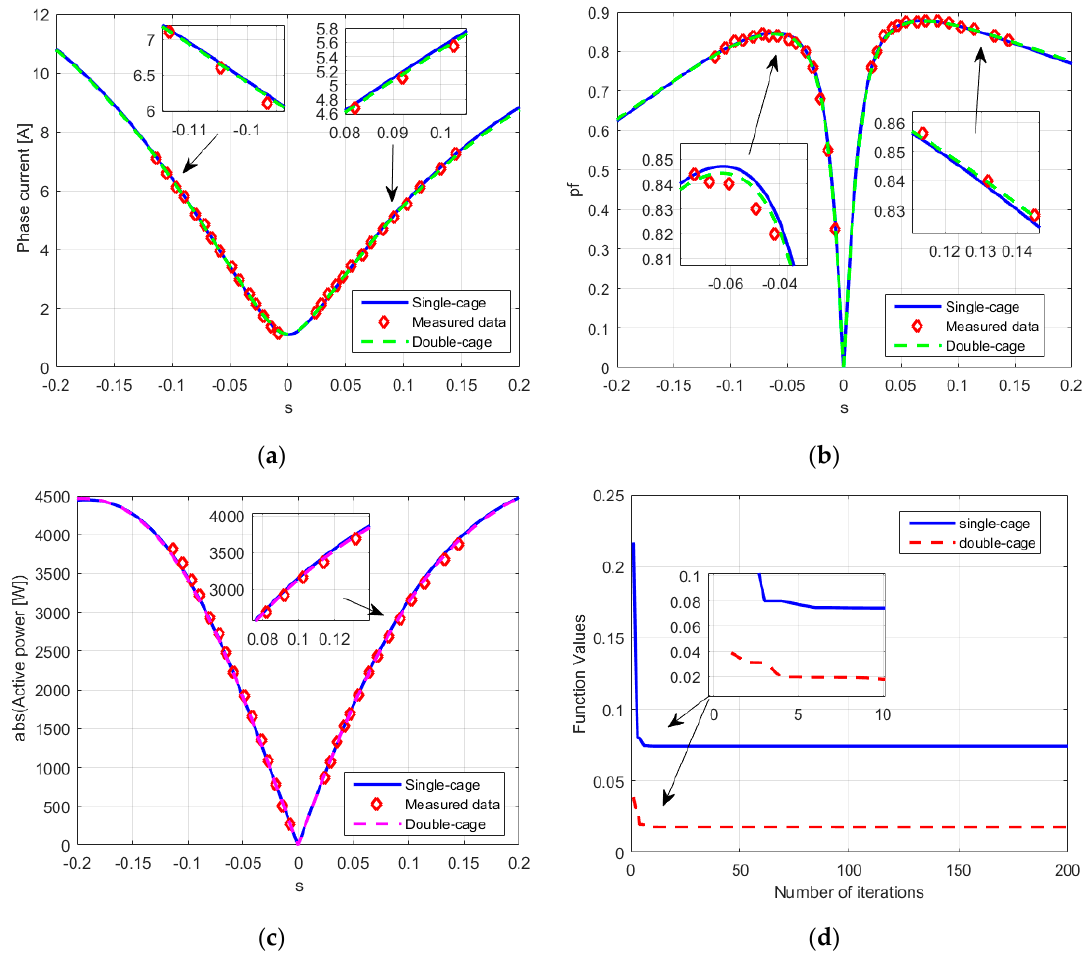
Figure 11. Experimental results: ( a ) Phase current versus slip; ( b ) power factor versus slip; ( c ) active power versus slip; and ( d ) convergence characteristics of considered machine when applying the proposed algorithm.